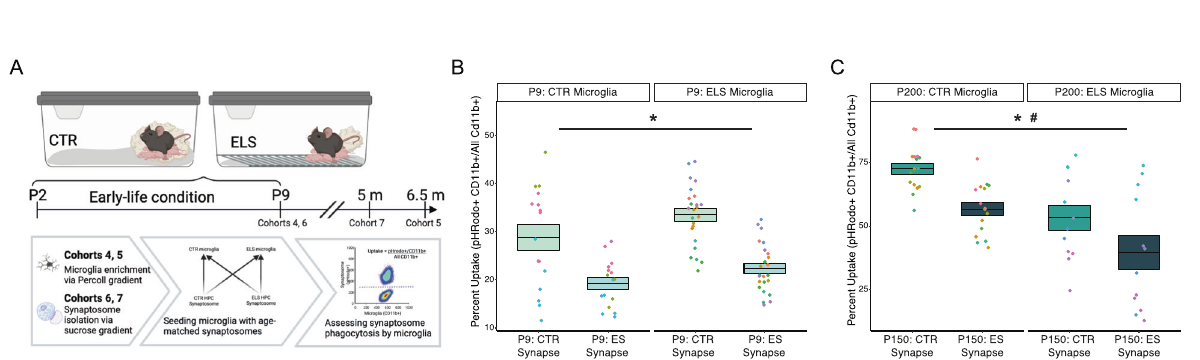
Fig. 3 ELS alters the microglia immune response to LPS. A Four-way plot depicting gene expression changes in response to LPS (LPS vs. PBS) in ELS and CTR microglia (logFC < />1, FDR < 0.05, Tables S12, S13). Each dot represents a gene. CTR-speci fi c LPS-responsive genes are marked in turquoise and orange, whereby the turquoise dots mark DEGs relatively lowest and orange dots mark DEGs relatively abundant expressed in CTR-LPS compared to CTR-PBS. ELS-speci fi c LPS-responsive genes are marked in dark turquoise and dark orange, whereby the dark turquoise dots mark DEGs relatively lowest and the dark orange dots mark DEGs relatively abundant expressed in CTR-LPS compared to CTR-PBS. Overlapping genes in the LPS response of ELS and CTR microglia are marked in gray. B , C Alluvial plots illustrating the top 5 enriched parent GO terms, for upregulated ( B ) and downregulated ( C ) genes in LPS- compared to PBS-treated CTR and ELS microglia. Signi fi cant GO terms ( p < 0.05) for each experimental group were reduced into parent GO terms (Tables S14, S15), which were ranked based on the total gene count belonging to that parent GO term. Color indicates the experimental group and ribbon thickness depicts the number of genes overlapping with parent GO term-speci fi c genes. D Venn diagram depicting the gene expression overlap between ELS- (P200: ELS-PBS vs. P200: CTR-PBS, Table S3) and LPS- (P200: ELS-LPS vs. P200: ELS-PBS and P200: CTR-LPS vs P200: CTR-PBS) introduced transcriptomic differences in P200 ELS and CTR microglia. E Heatmap depicting z scores of logCPM of primed/trained genes (cluster 3, Fig. S3, Table S16). F Venn diagram showing gene overlap between genes detected to be primed/trained by ELS and LPS (cluster 3, Table S16) and trained genes detected by Holtman et al. [54] (Table S2). CTR control, ELS early-life stress, LPS lipopolysaccharide, PBS phosphate-buffered saline.